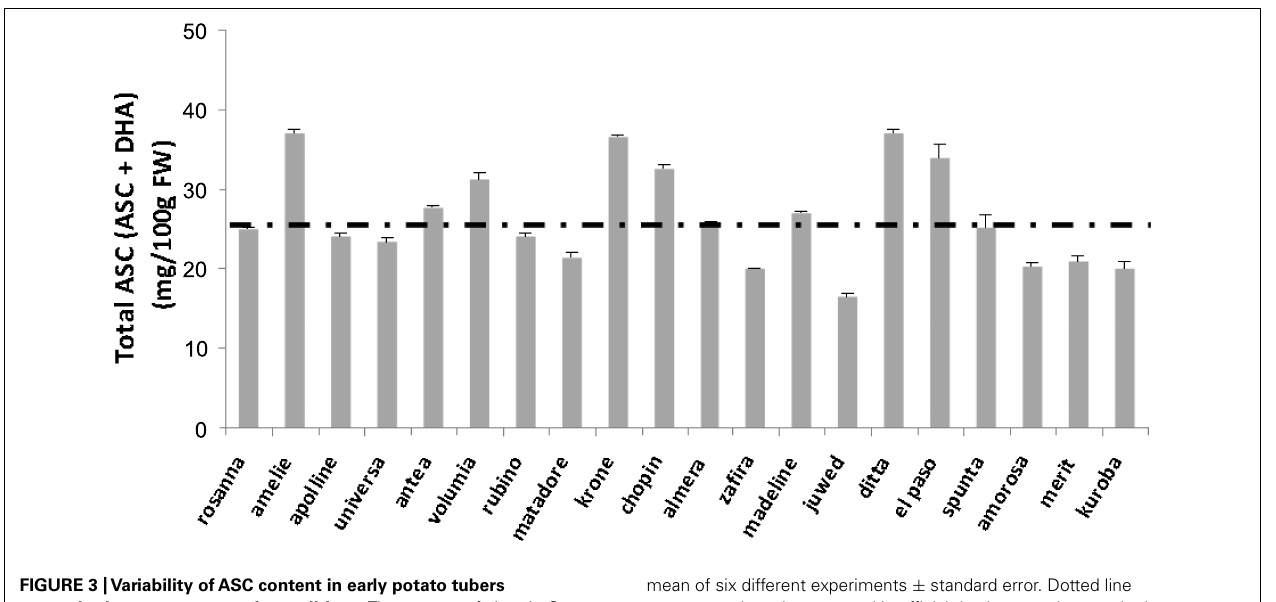
FIGURE 3 |Variability ofASC content in early potato tubers grown in the same agronomic conditions. The content of vitamin C in 20 cultivars of early potato grown in the same experimental field in Apulia Region (southern Italy) is reported.The values are the